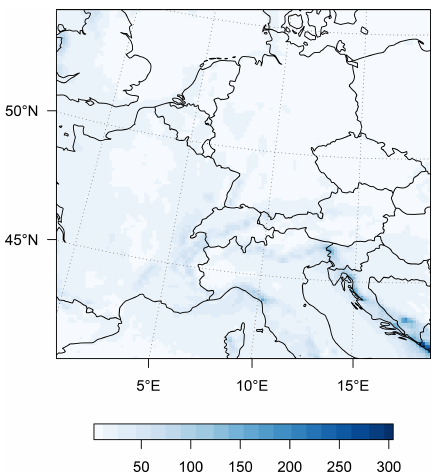
Figure 5. Proportion of variance explained ( R 2 ) for each grid cell for the precipitation